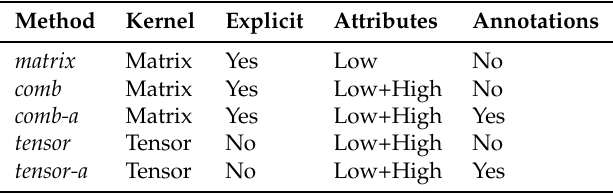
Table 7. Overview of iterative clustering schemes (Source: